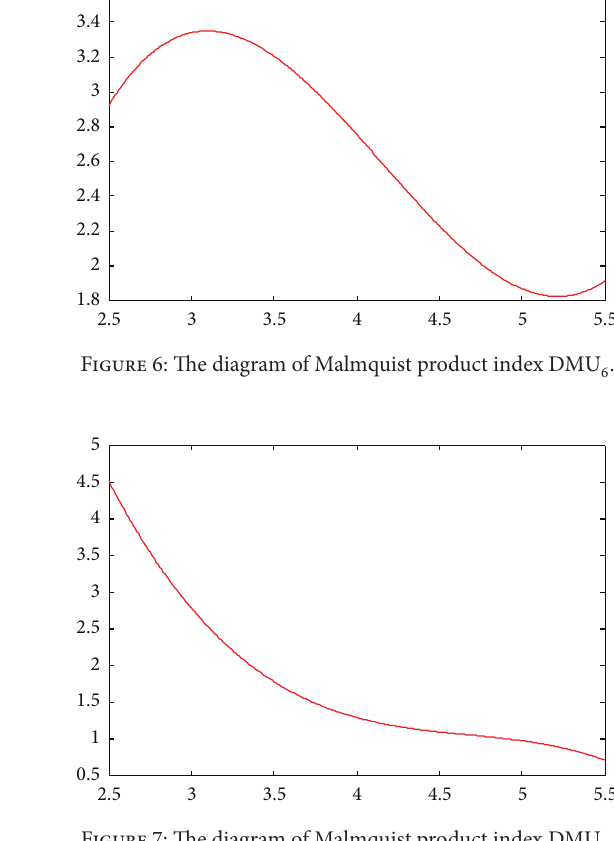
Figure 7: The diagram of Malmquist product index DMU 7